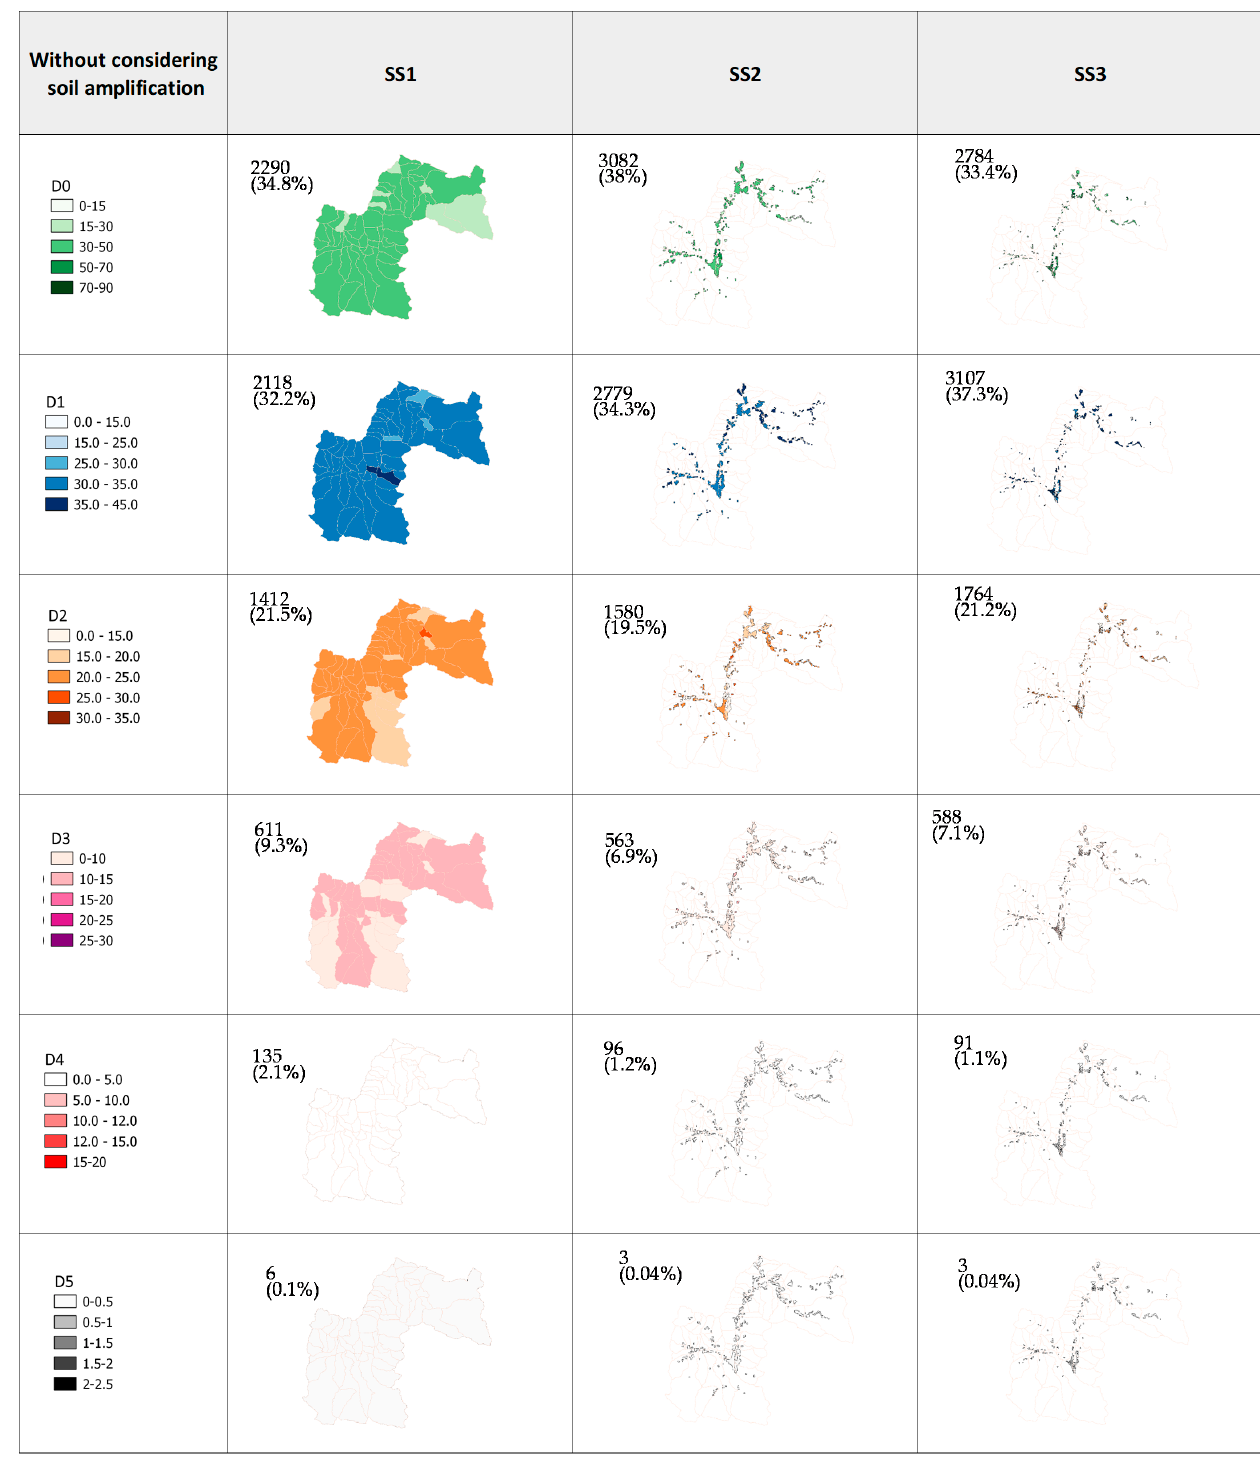
Figure 4. The damage distribution per scale scenario without considering the ground motion amplification due to soil effects. The color shows the percentage of buildings per level of damage. The number shows the total number of damaged